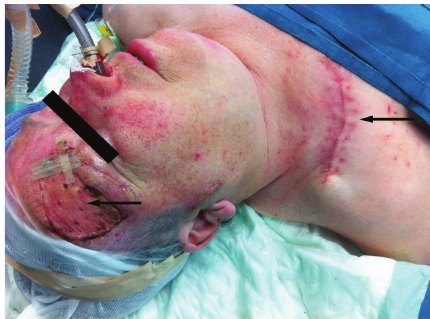
F 1: Patient with Merkel cell carcinoma of the right eyebrow (arrow). Primary excision site was covered by full thickness skin taken from the right clavicular/subclavicular region (arrow).